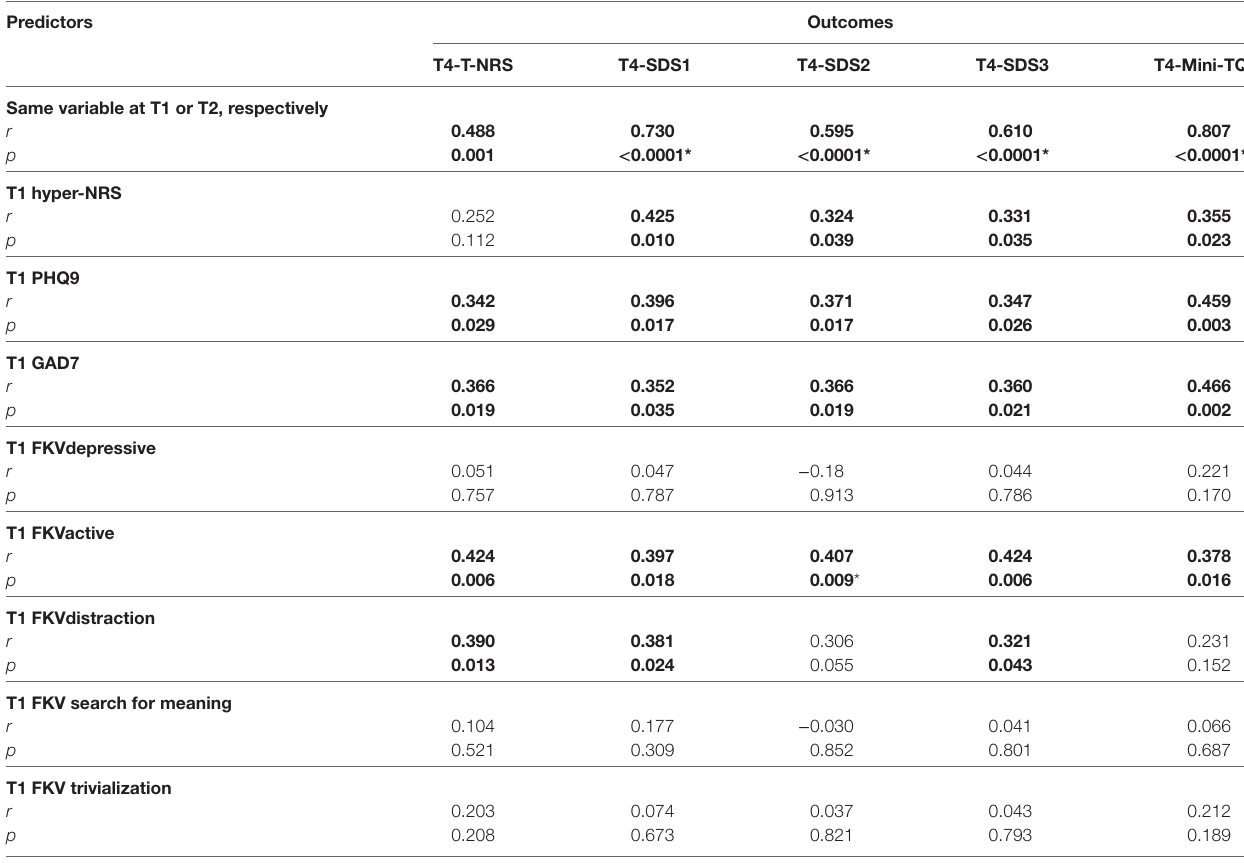
TaBle 5 | Pearson correlation coefficients ( r ) for bivariate correlations between predictor variables at T1 and outcome variables at T4 are shown together with p -values.